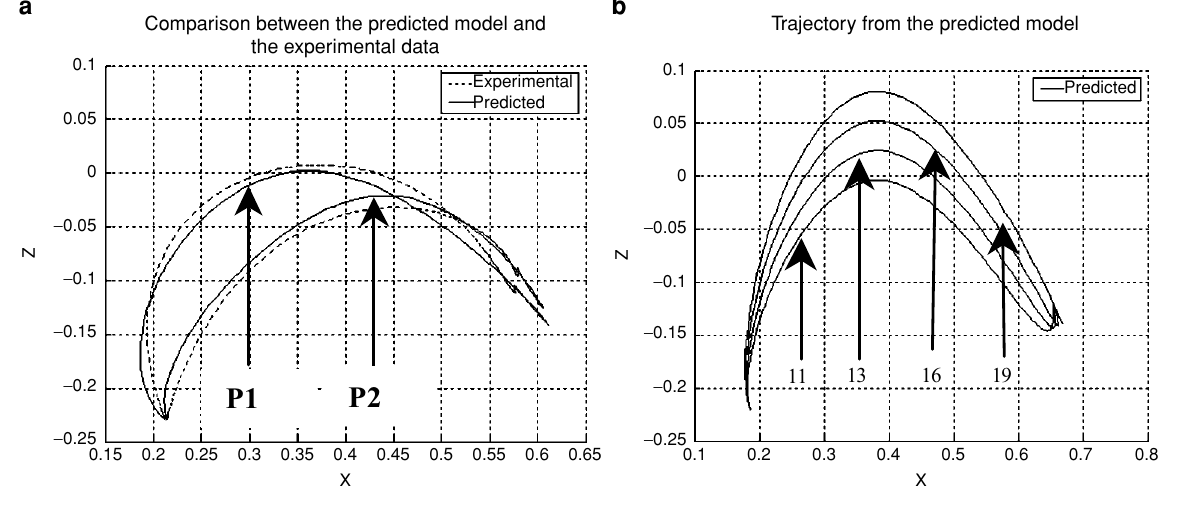
Figure 10 Simulated trajectory. (a) Wrist. (b)